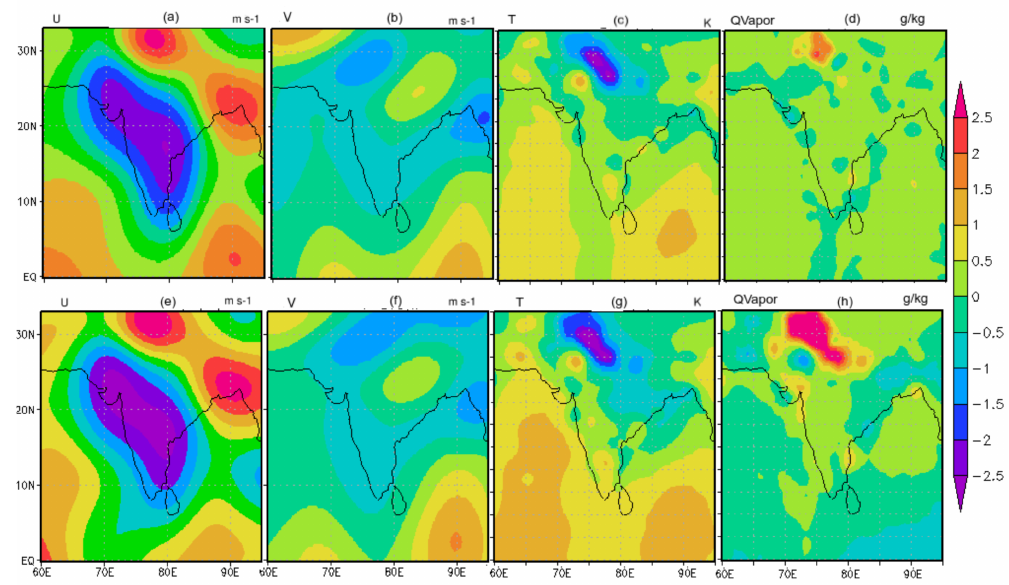
Figure 4. Analysis increment at model level 1 in zonal wind (a, e) meridional wind (b, f) , temperature (c, g) and water vapour mixing ratio (d, h) for the cv5 option (a–d) and the cv6 option (e–h) for the first depression case due to assimilation of all available